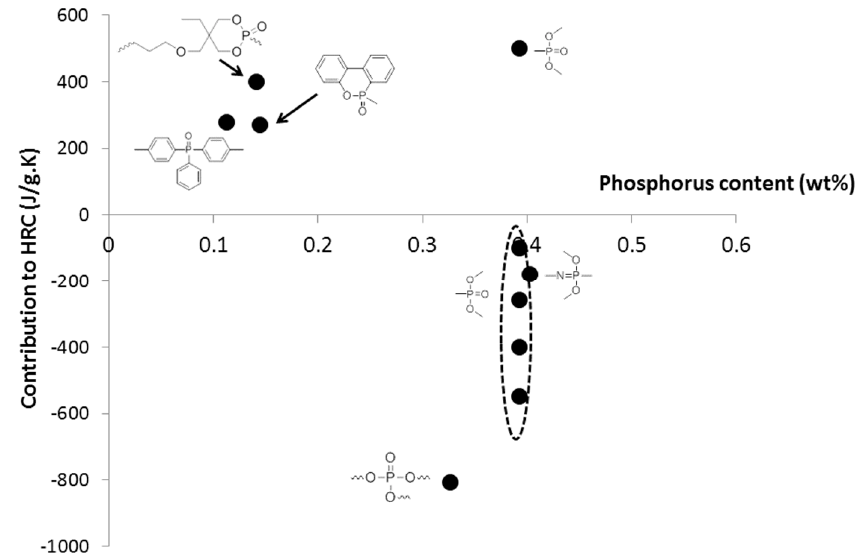
Figure 11. Contributions to HRC for various phosphorus-containing groups according to different works.